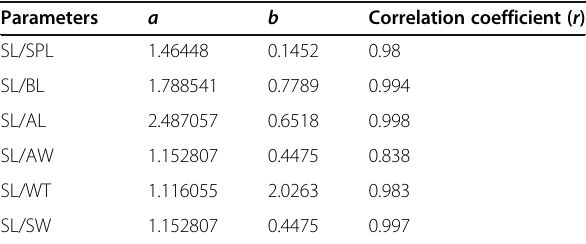
Table 1 Results of establishment of relationships between different parameters of Pila globosa through correlation